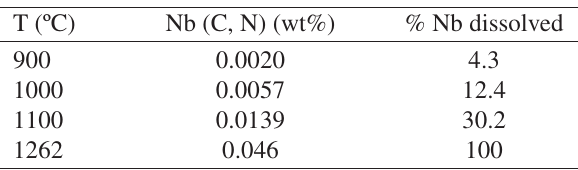
Table 2: Amount of Nb dissolved in the austenite as a function of